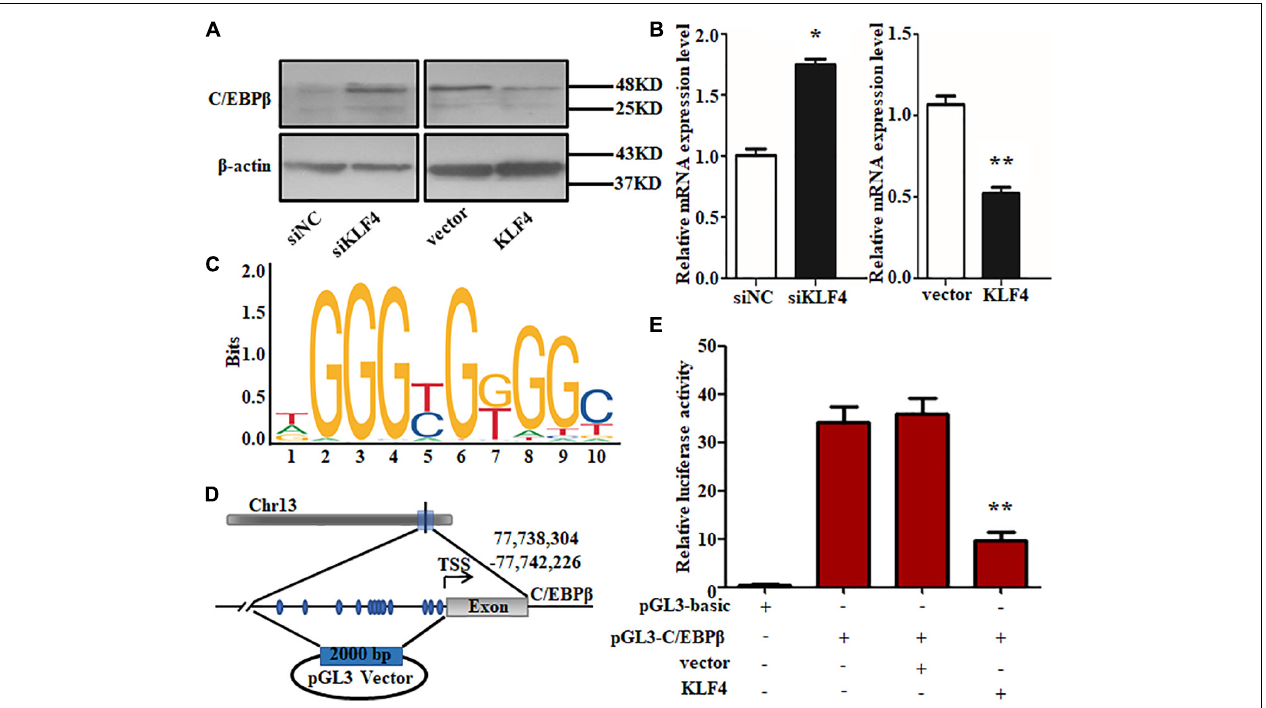
FIGURE 7 | KLF4 effects on intramuscular adipocyte differentiation through targeting C/EBP β directly. The protein (A) and mRNA (B) levels of C/EBP β in KLF4 siRNA and adenovirus-treated cells. (C) KLF4 binding DNA motif. (D) The predicted of KLF4 binding sites at C/EBP β promoters. (E) Luciferase assay of transfected with pGL3-C/EBP β P in goat intramuscular adipocytes. The data are presented as the mean values ± SD. Each experiment was performed at least in triplicate, producing consistent results. * p < 0.05, ** p <